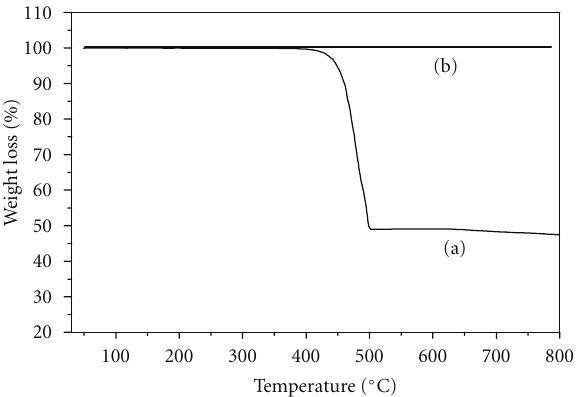
Figure 4: TG curves of (a) silver nitrate and (b) BaTiO 3 -CuO mixed oxides.